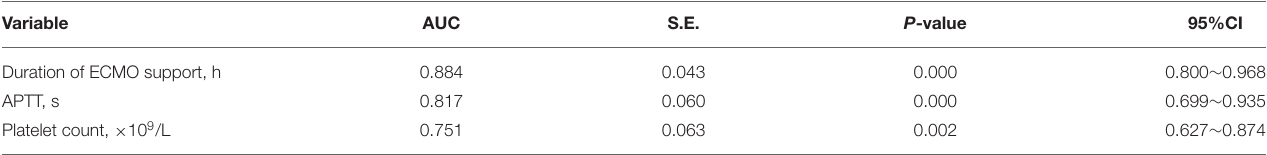
TABLE 5 | ROC curve analysis and characteristic parameters.